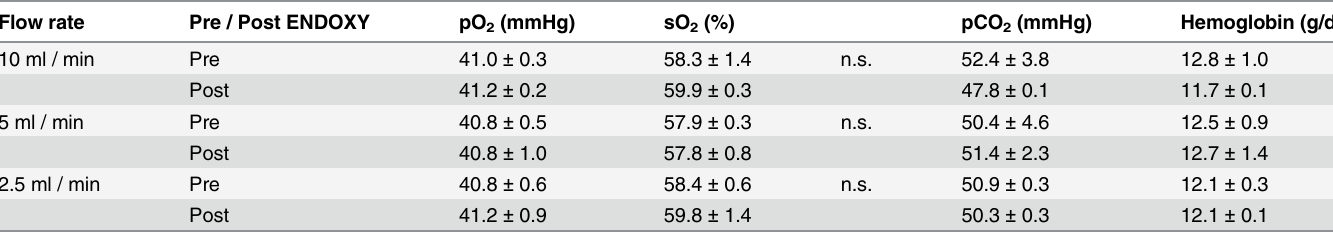
Table 3. Gas transfer measurement of cell coated Lumox ™ slide — blood gas analysis.